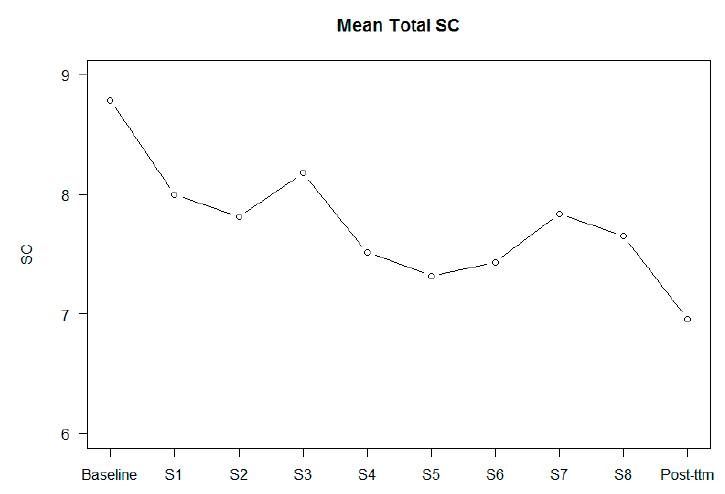
Figure 2. Changes in self-certainty (SC) in every session and in the post-treatment.